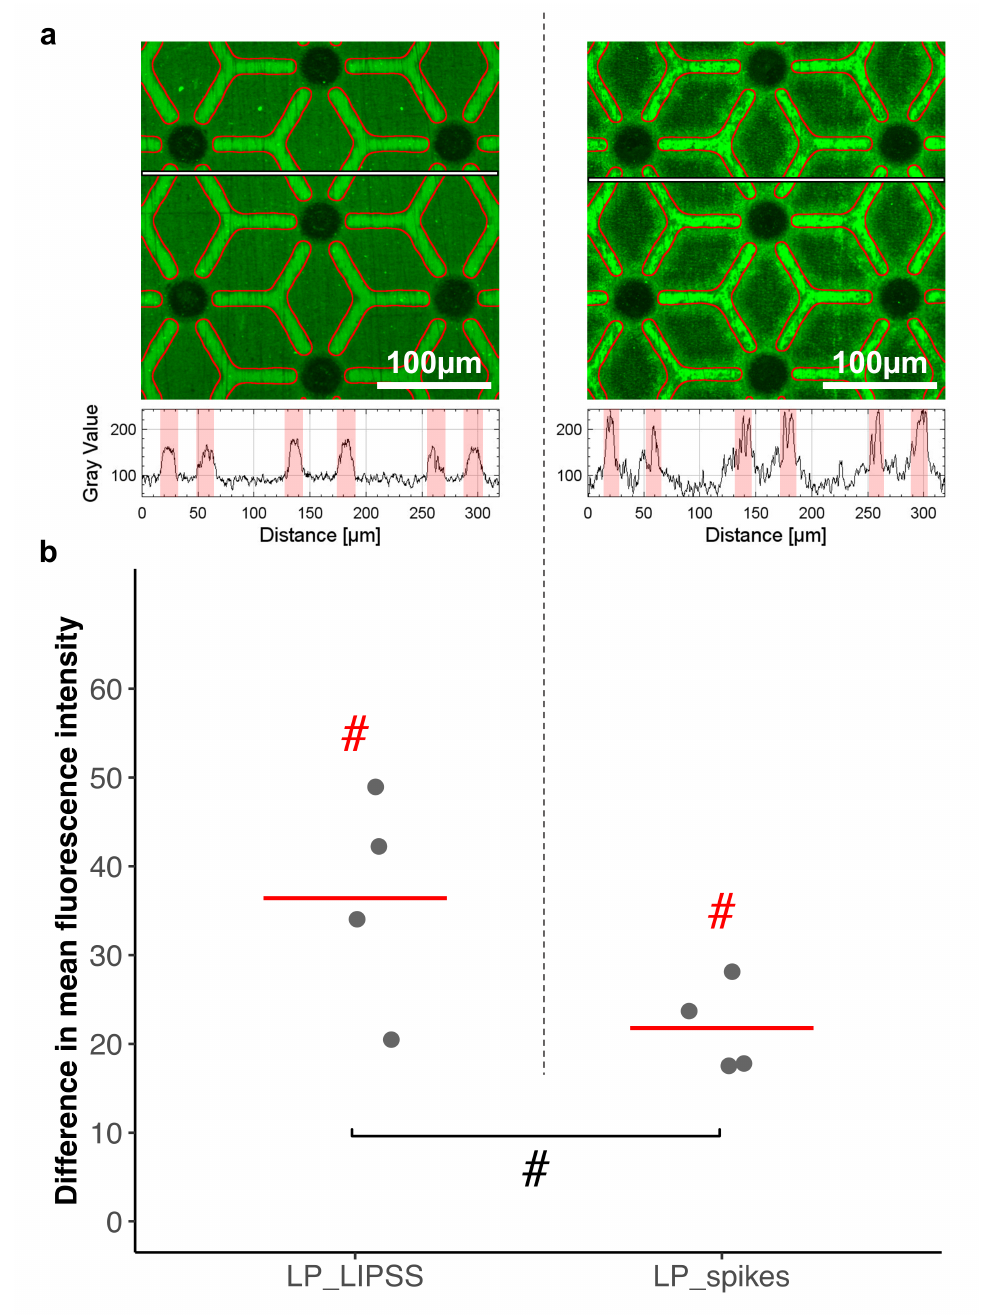
Figure 7. Comparison of albumin adsorption on polished areas and nanostructured areas. Fluorescent albumin was detected on laser-patterned surfaces with LIPSS (LP_LIPSS) or spikes (LP_spikes). ( a ) Representative image of fluorescence intensity. Polished areas are outlined in red, textured ones are the remainder ( top panel ). Respective profiles of the fluorescence intensity, red regions represent polished areas along the profile ( bottom panel ). ( b ) The di ff erence in mean fluorescence intensity between polished and textured regions is displayed according to an 8-bit grayscale. Four measurements on areas of 320 µ m by 320 µ m per sample were analyzed. The Mann–Whitney one-tailed statistic test was performed. Red lines denote mean values. # p -value < 0.1. Red hash signs denote di ff erences with the random theoretical value ( µ 0 =